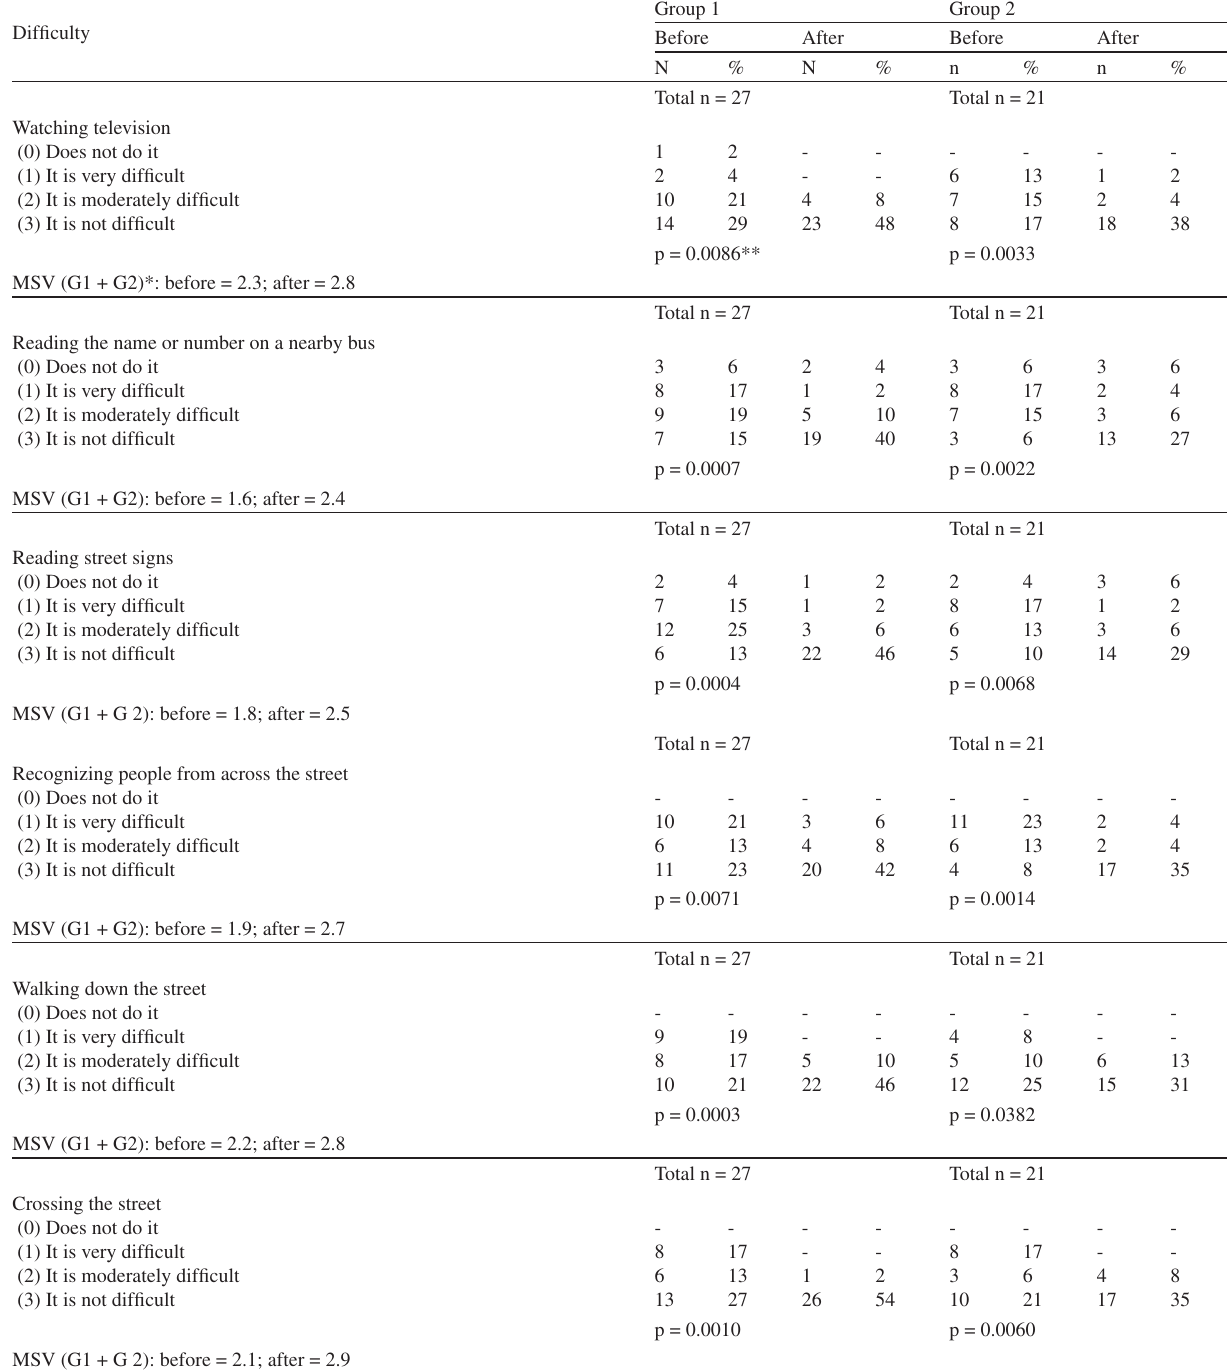
Table 4 - Perception of difficulties with activities related to distance vision before and after capsulotomy.